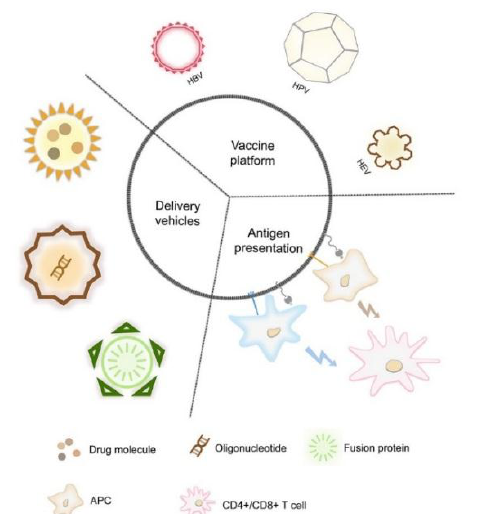
Figure 1. An overview of virus-like particles (VLPs) used as efficient nanocarriers for antigen presentation, cargo delivery, and as a vaccine platform.